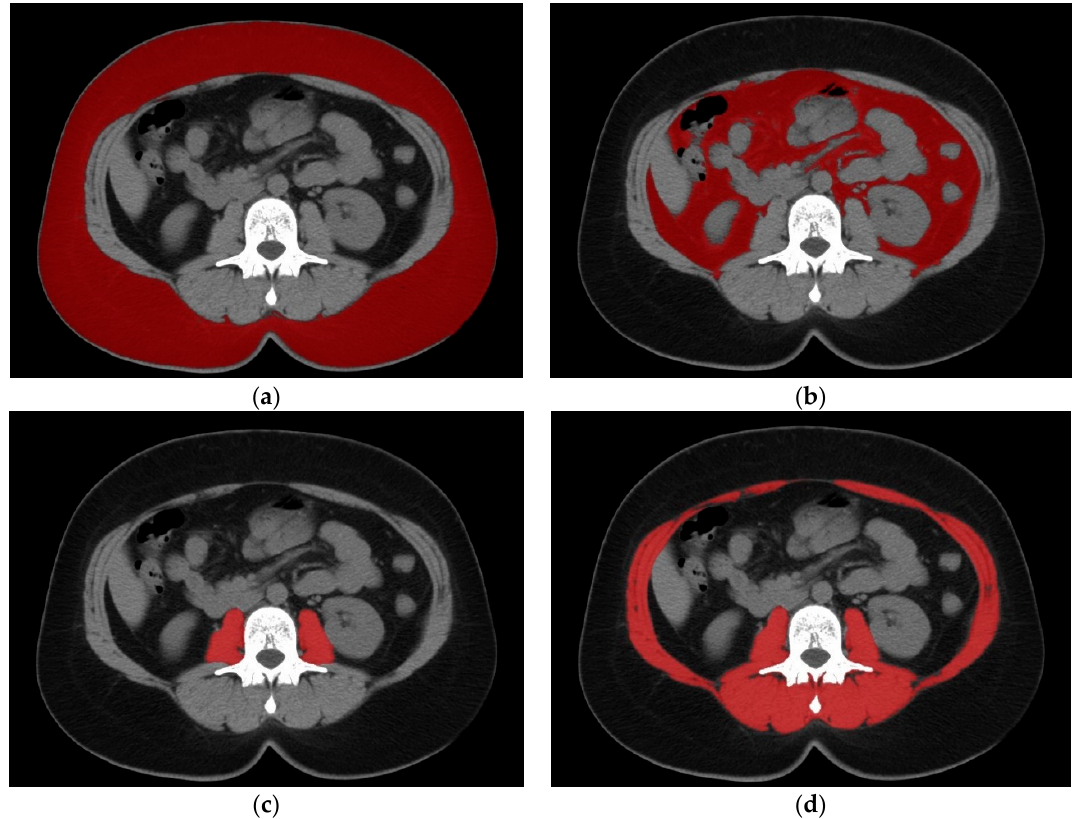
Figure 2. Examples of muscle and adipose tissue measurements: ( a ) Subcutaneous Fat Area ( b ) Visceral Fat Area ( c ) Psoas Major Area ( d ) Total Skeletal Muscle Area. ( a ) red zone represents Subcutaneous Fat Area, in this patient it was 332.6 cm 2 /m 2 ( b ) red zone represents Visceral Fat Area, in this patient it was (138.9 cm 2 /m 2 ) ( c ) red zone represents Psoas Major Area, in this patient it was 16.8 cm 2 / m 2 ( d ) red zone represents Total Skeletal Muscle Area, in this patient it was 123.2 cm 2 / m 2